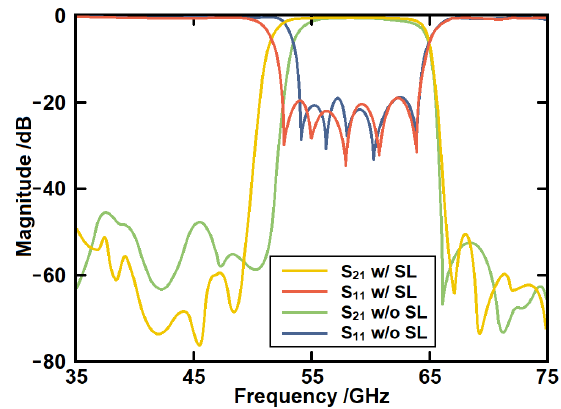
Figure 9. The topology of the SSPP structure with serpentine lines.